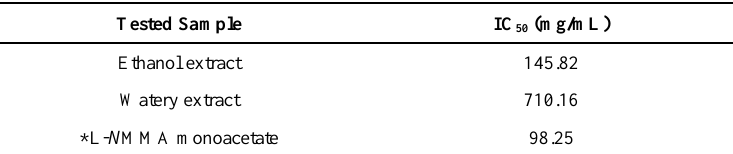
Table 8. Inhibition of NO production against LPS induced RAW264.7